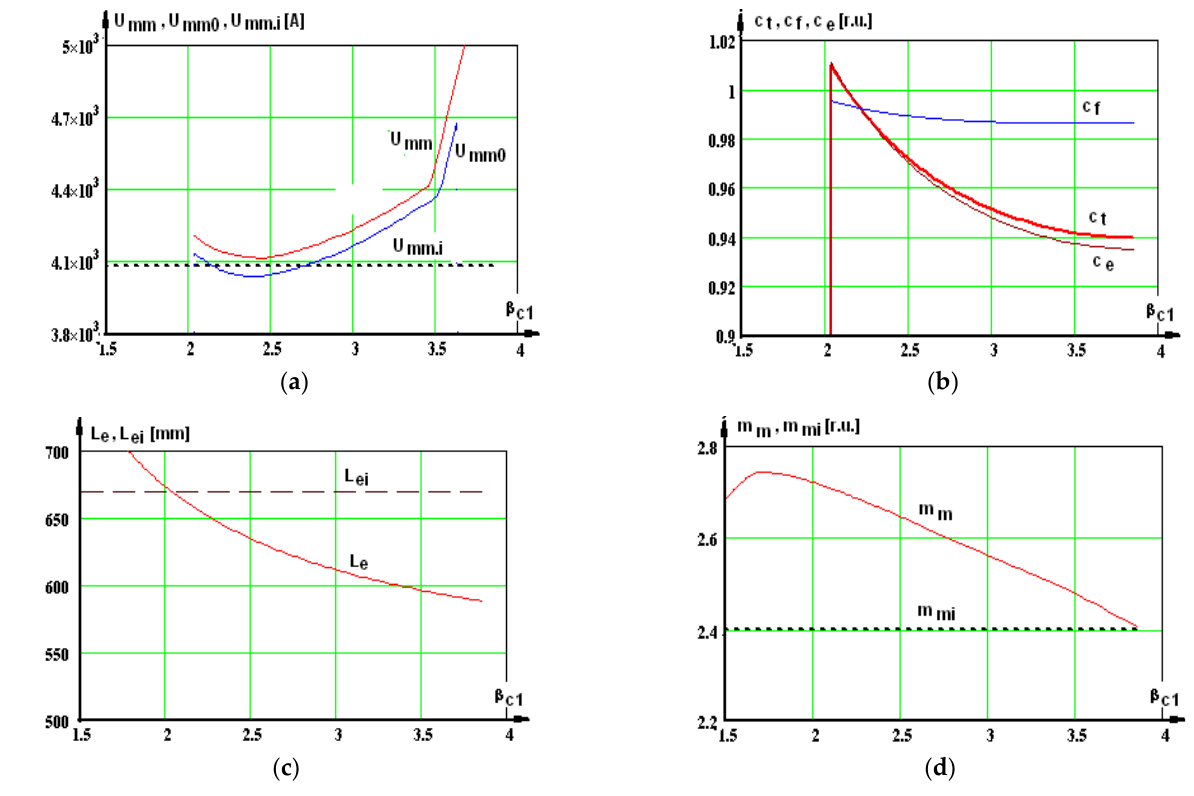
Figure 4. Variation curves relative to the variable β c 1 —stator slot shape factor for: ( a ) total ampere-turn for a pole pair U mm 0 / U mm / U mm.i —for optimized/real machine/imposed value; ( b ) c t / c f / c e —total/fabrication/exploitation cost; ( c ) total length; and ( d ) maximum torque. Table 4. The values obtained for the analyzed